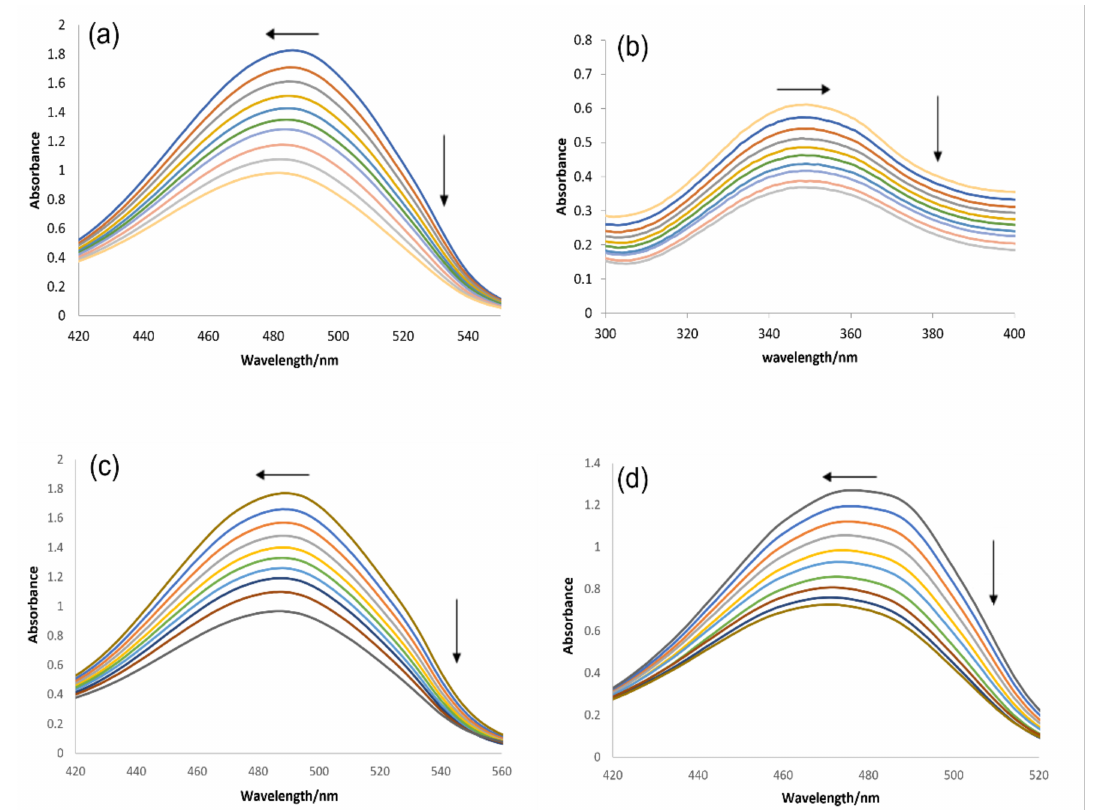
Figure 6. UV-visible responses of ( a ) IST-01, ( b ) IST-02, ( c ) IST-03, and ( d ) IST-04 before and after DNA titrations, along with the arrows representing changes in absorbance peak intensity and wavelength shift.